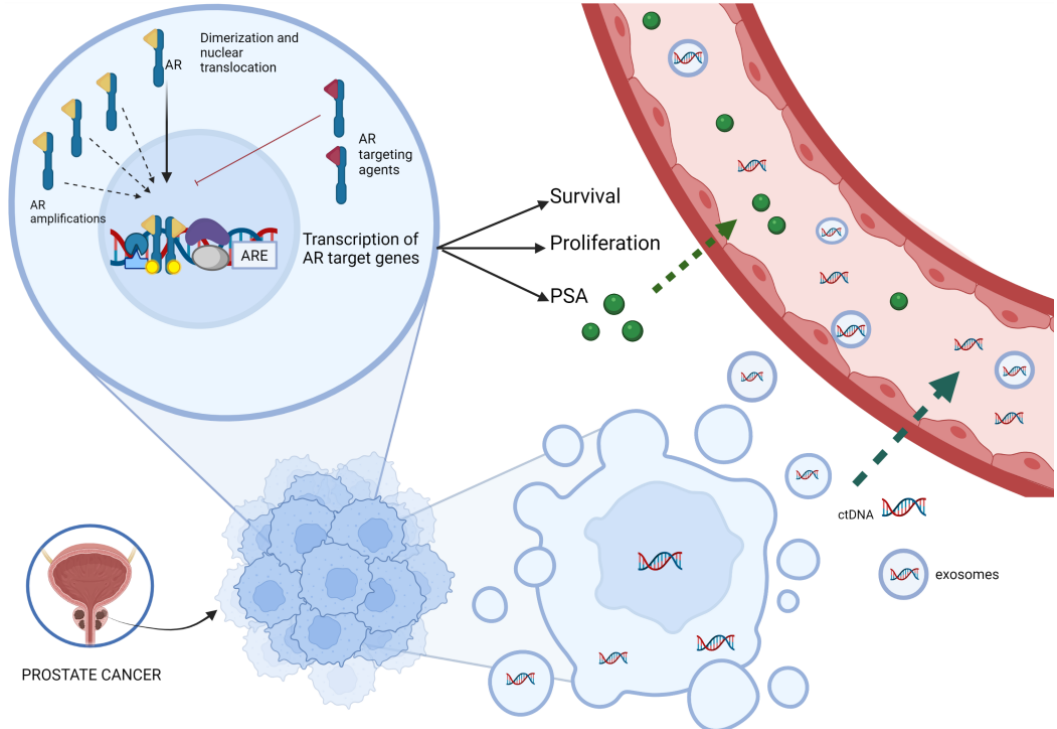
Figure 1. Correlation between ctDNA, AR amplification and PSA kinetics. The picture synthesizes the role of AR and its action mediated by various transcriptional co-regulators. Activation of target genes leads to biological responses including growth, survival and the production of PSA. The AR targeting agents could inhibit this pathway, but the onset of AR amplification can bypass this inhibition. ctDNA is released from dying cancer cells, or, more rarely, from living tumor cells that actively release DNA and exosomes into the circulation because of oncogenic properties. Abbreviations: AR, androgen receptor, ARE, androgen response elements; ctDNA, circulating tumor DNA; PSA, prostate specific antigen.